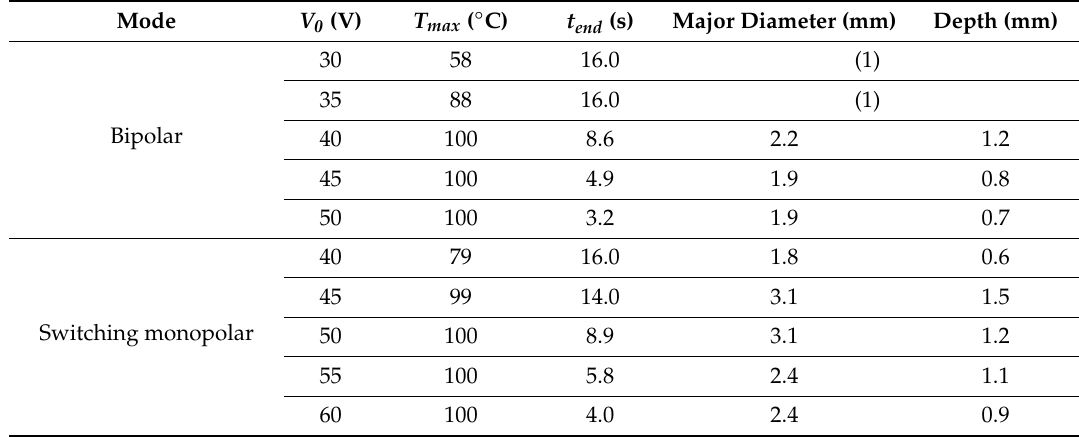
Table 2. Results obtained in the first set of simulations for bipolar and switching monopolar modes showing the level of voltage used, the t end and maximum temperature and stop time values, and the major CZ diameter and depth (measured according to Figure